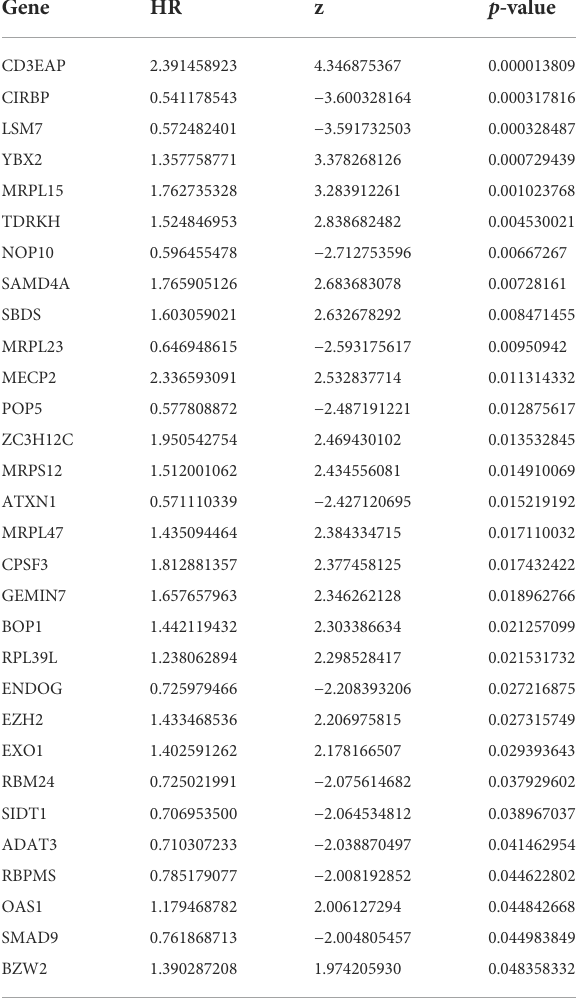
TABLE 2 Unicox results of differential